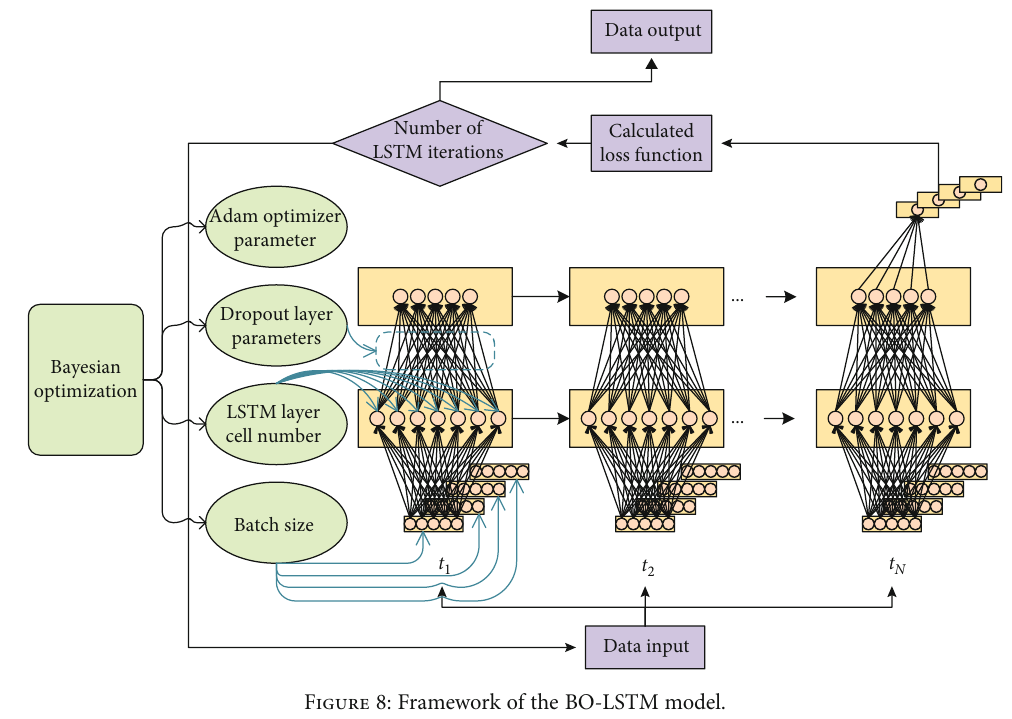
Figure 8: Framework of the BO-LSTM model.